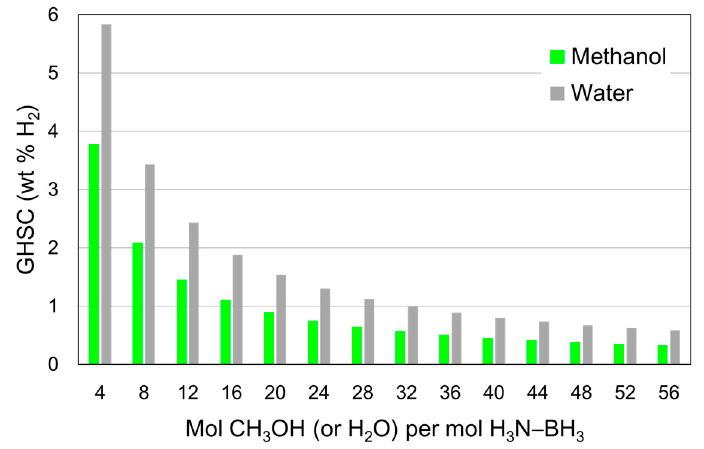
Figure 6. Evolution of the gravimetric hydrogen storage capacity (GHSC) of the couple ammonia borane–methanol as a function of the mole number of methanol per mole of ammonia borane. For comparison, the evolution for the couple ammonia borane–water is also shown.